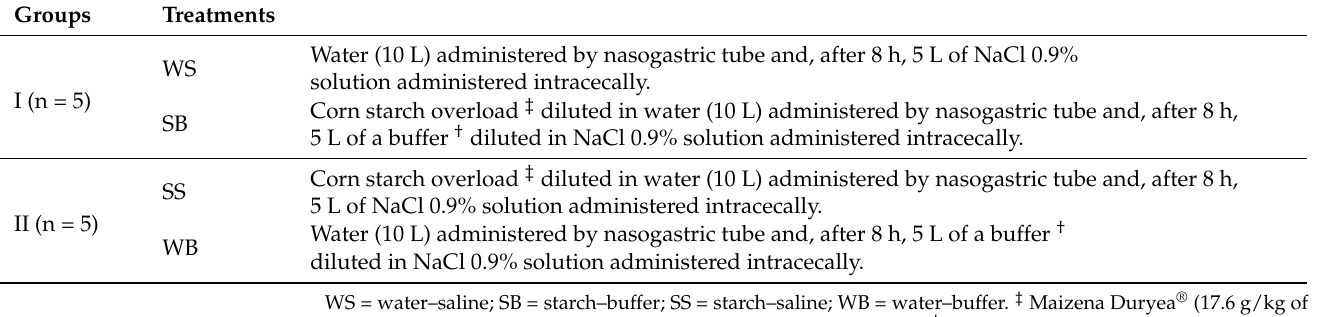
Table 1. Groups and treatments of horses exposed or not to starch overload and/or